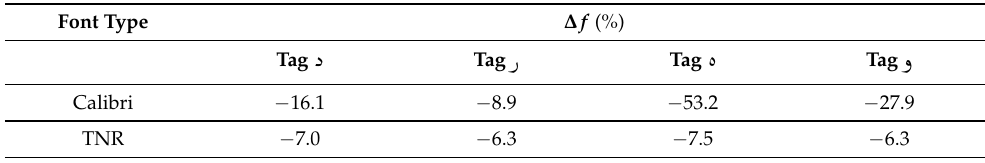
Table 6. Change in resonance frequency ( ∆ f ) in % in vertical polarization for analyzed tags for changing font types with reference to Arial font type.